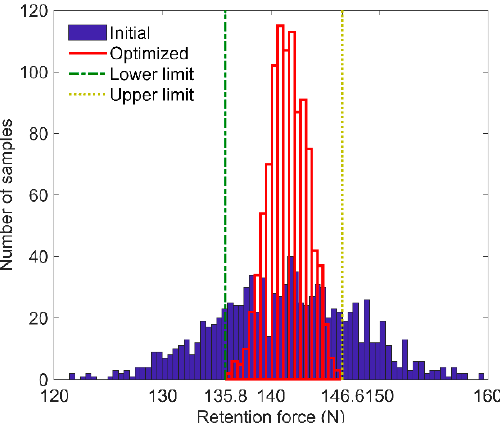
Figure 14. The distribution of retention force after robust optimization.